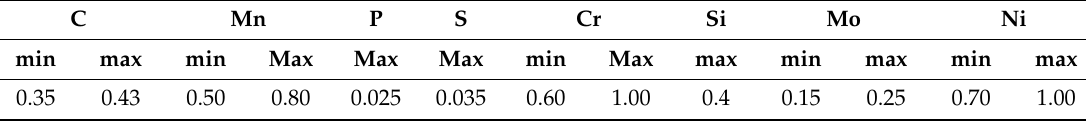
Table 1. Nominal chemical composition 39NiCrMo3 steel (wt